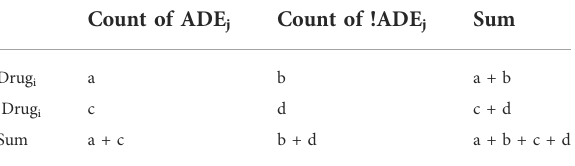
TABLE 1 2 × 2 contingency table for computation of